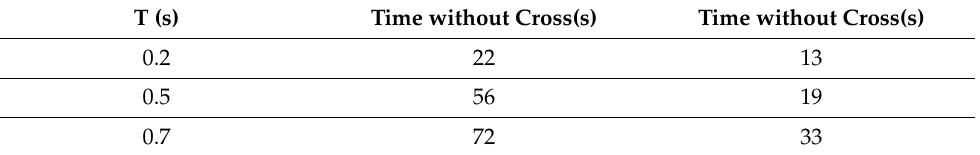
Table 1. Execution times of the two SPIM models with and without cross-saturation. T (s) Time without Cross(s)